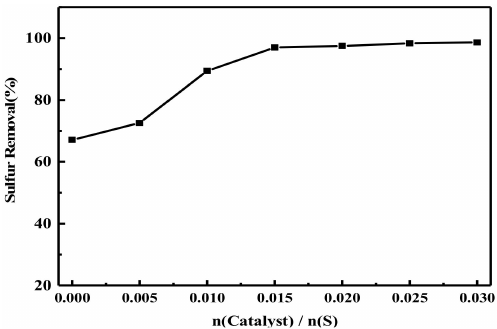
Figure 6. Effect of the mole ratio of catalyst to sulfide on desulfurization. Reaction conditions: V(oil) = 5 mL; n(H 2 O 2 )/n(S) = 6; V(acetonitrile) = 0.5 mL; t = 60 min; T=50 ◦